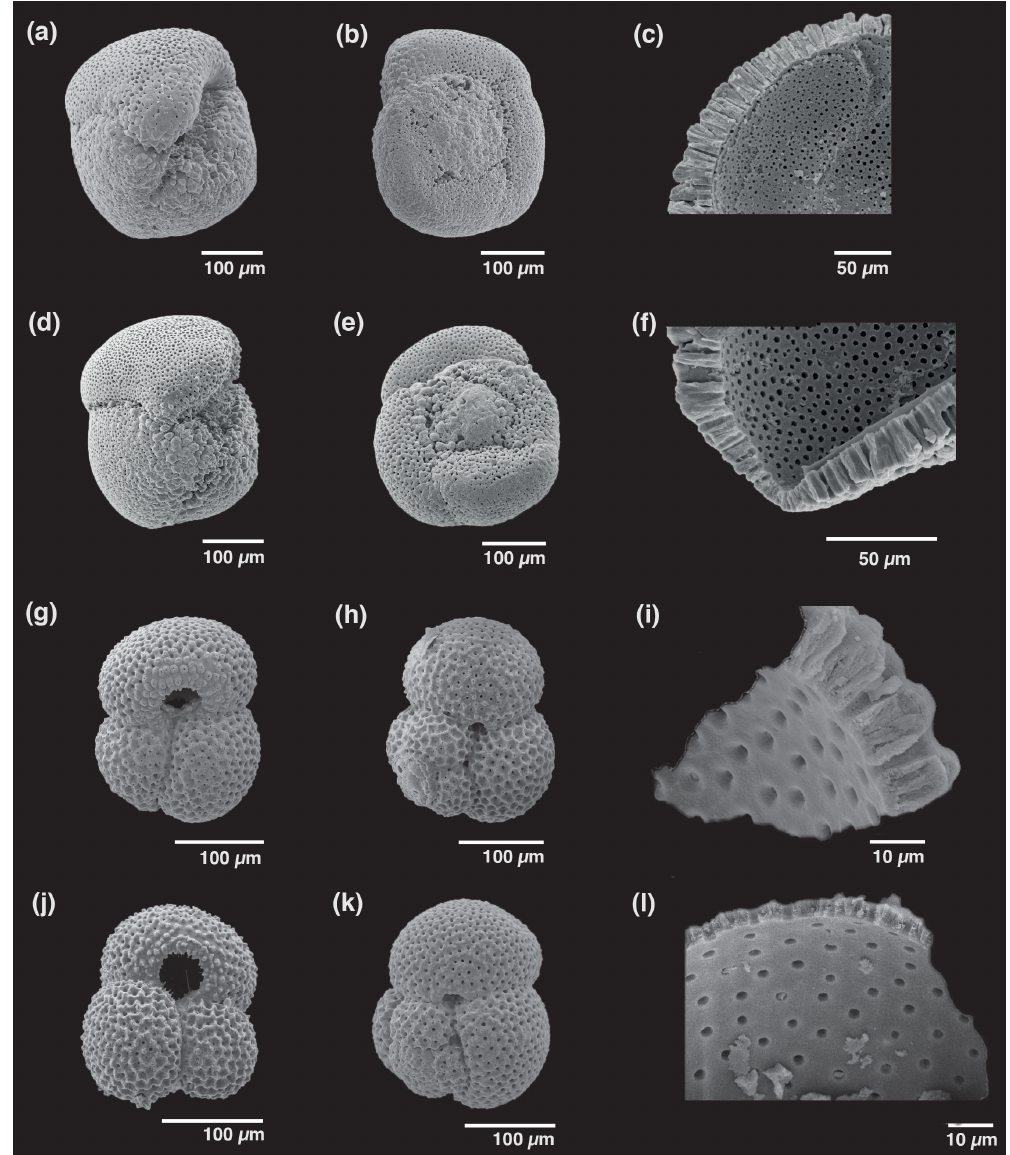
Figure 3. Scanning electron micrographs of Globorotalia crassaformis and Globigerinoides ruber from Site 849. Both glacial (a–c, g–i) and interglacial (d–f, j–l) foraminiferal tests are well preserved, allowing for the acquisition of reliable geochemical